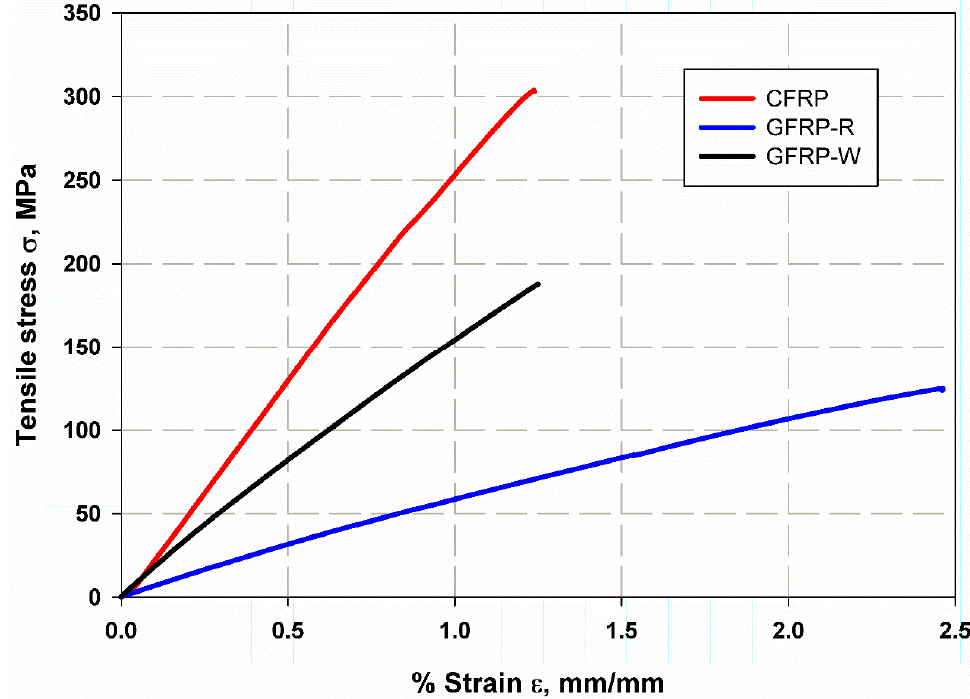
Figure 8. Stress and strain relation for un-notch tensile strength of composite laminates.